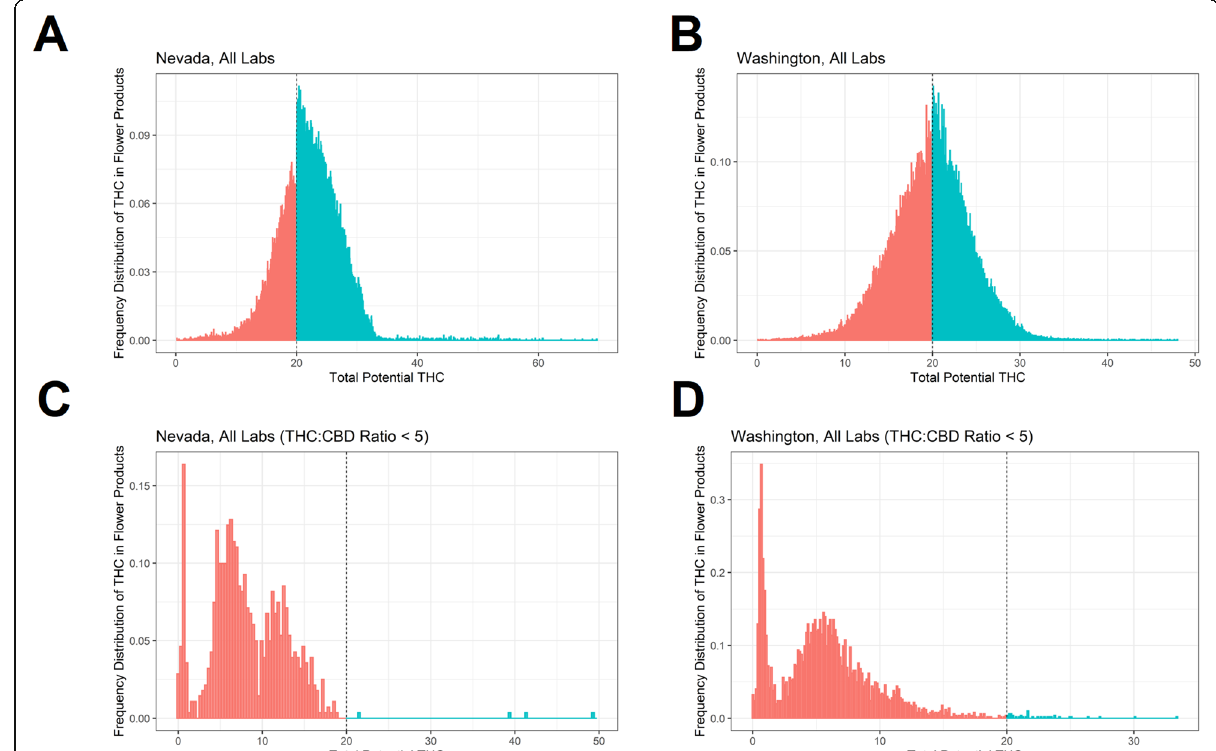
Fig. 3 Sensitivity tests including products above 35% THC and products with THC:CBD ratios of less than 5. This figure consists of four plots showing histograms of the frequency of reported THC, with bins to the left of the 20% threshold shaded red and bins to the right of the 20% threshold shaded blue. The top row is similar to the top row of Fig. 1, except that products above 35% THC are included, and there is no left-truncation of plots at 10% THC. The top left plot (panel a ) shows data from Nevada and the top right plot (panel b ) shows data from Washington state; both panels show a spike in reported THC concentrations around the 20% threshold. The bottom row shows the THC frequencies for flower products with THC:CBD ratios of less than 5 (i.e., mixed or predominantly CBD products) in Nevada (panel c ) and Washington (panel d ). Histogram bins were generated via the DCdensity function. In both states, there are few products with such THC:CBD ratios around the 20% THC